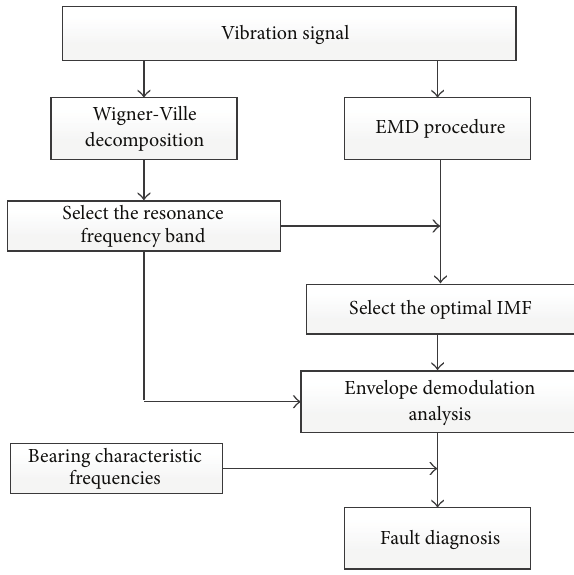
Figure 1: Flow chart of fault